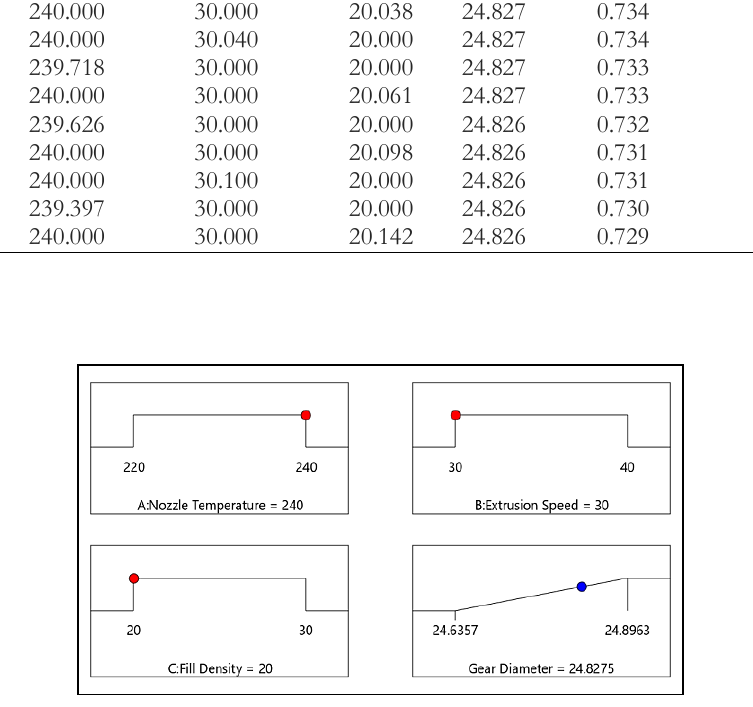
Fig. 7. Optimal parameters for gear bore diameter from RSM